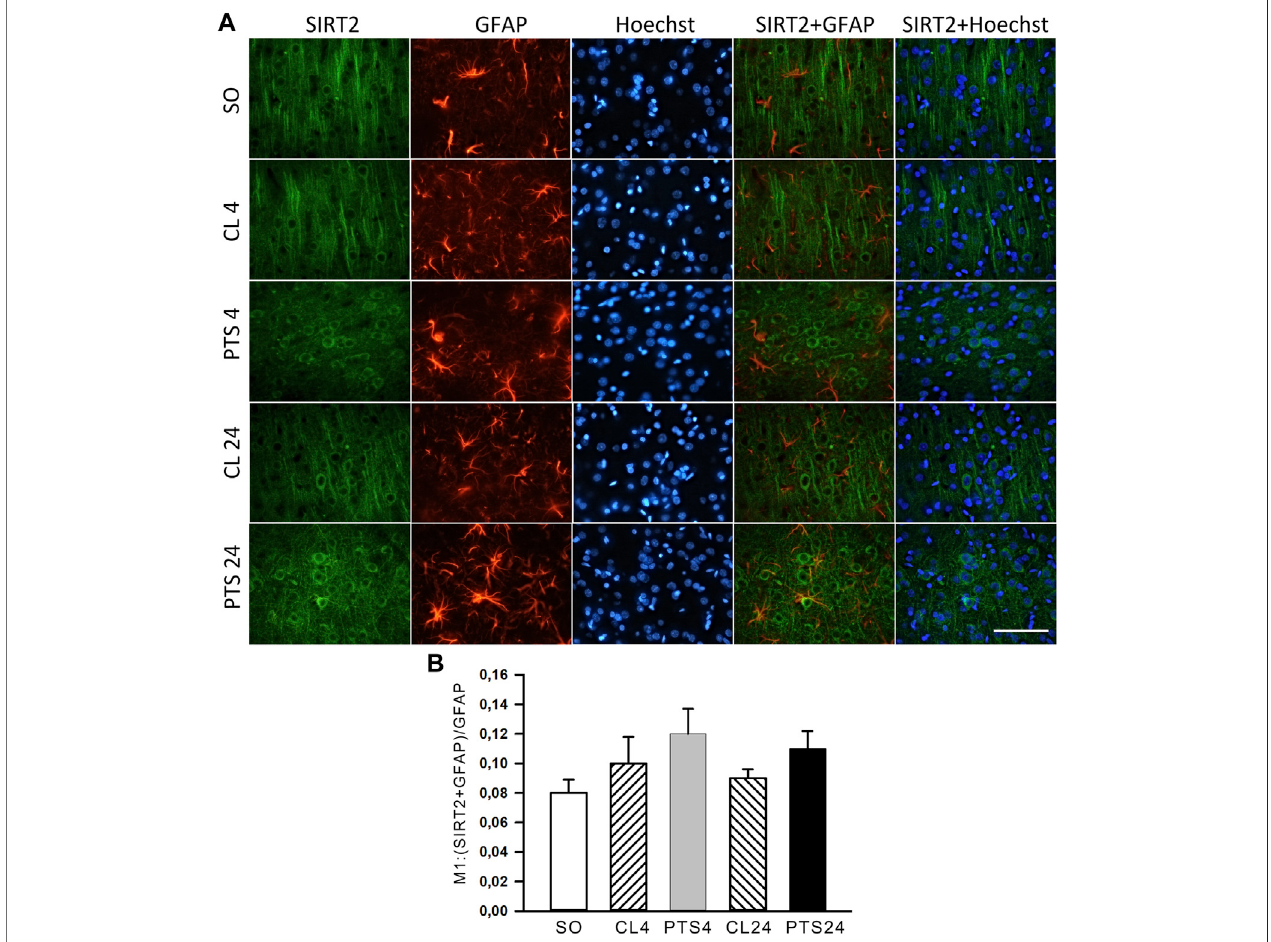
FIGURE 6 | SIRT2 levels in astrocytes of ischemic penumbra 4 and 24 h after photothrombotic stroke in the rat cerebral cortex (PTS4 and PTS24, respectively) compared to the same animals ’ contralateral cortex (CL4 and CL24), or the cortexof sham-operated animals(SO). (A) Immuno fl uorescence ofSIRT2 (green), marker of astrocytesGFAP(red), nuclearchromatin markerHoechst 33342(blue), andimageoverlay. Thescalebar is100 μ m. (B) Coef fi cientM1ofSIRT2co-localizationwiththe astrocyte marker GFAP in different control and experimental groups. One Way ANOVA; M ± SEM; n = 7.